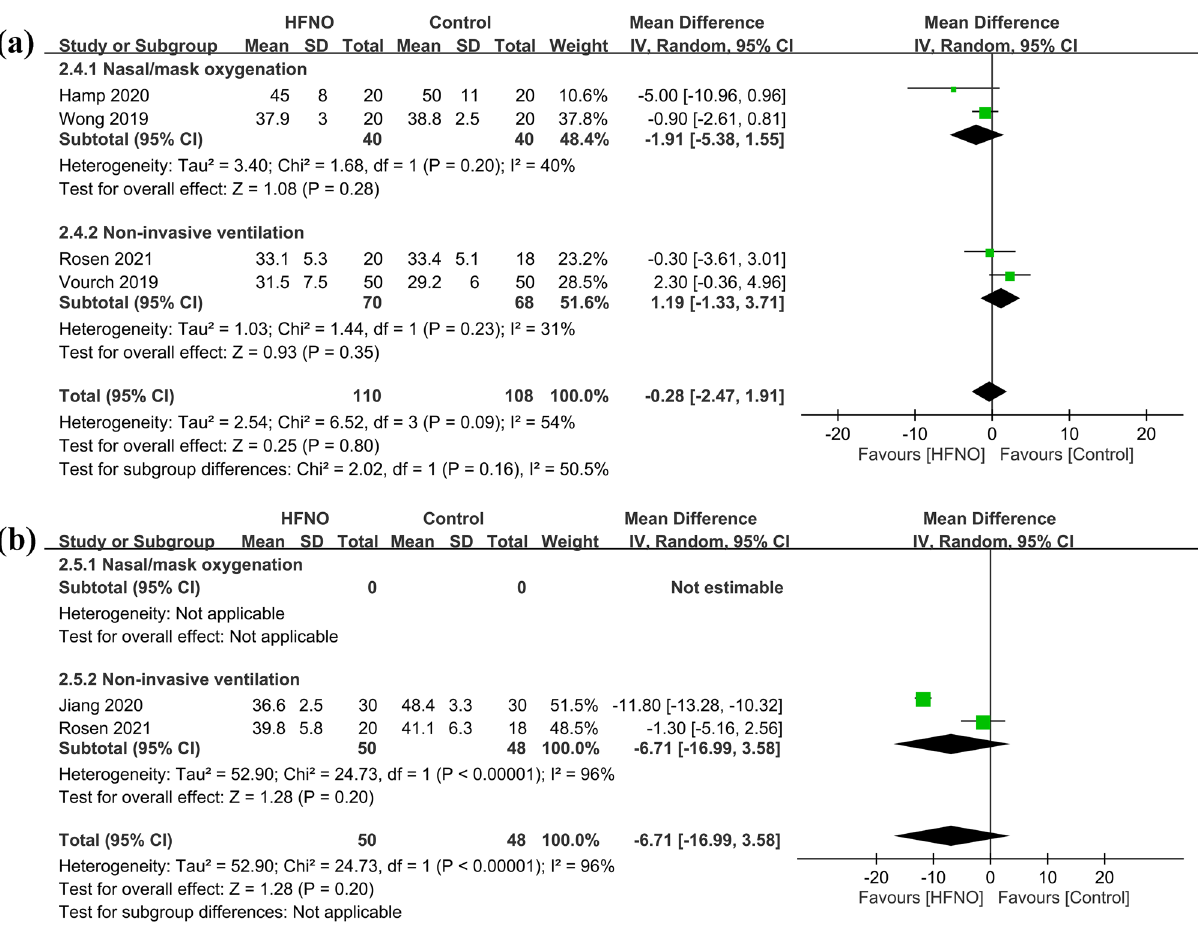
Figure 5. Forest plot comparing ( a ) EtCO 2 and ( b ) PaCO 2 between HFNO and control groups. HFNO, high- flow nasal oxygenation; IV, inverse variance; CI, confidence